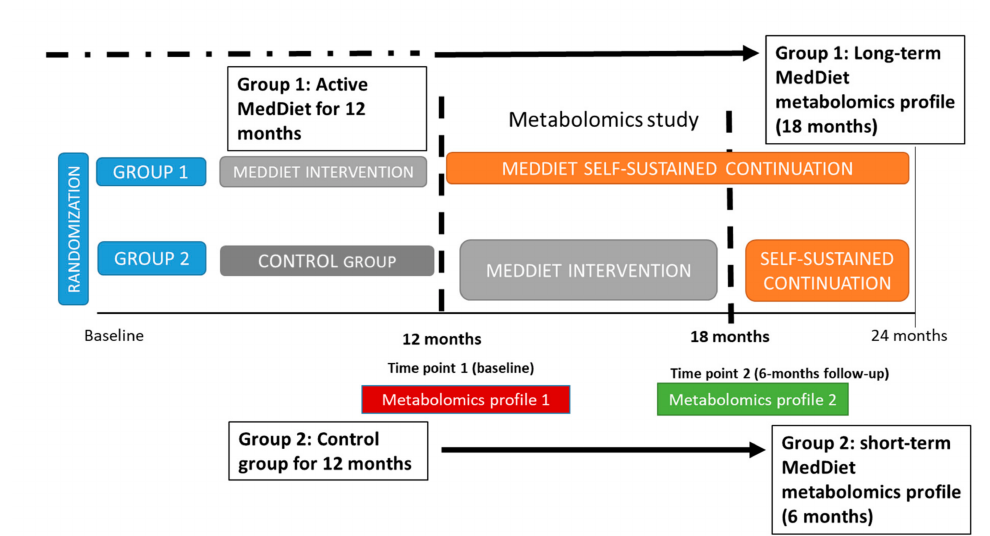
Figure 1. Study design and timeline of the metabolomics study within Feeding America´s Bravest parent study (step-wedge cluster-randomized control